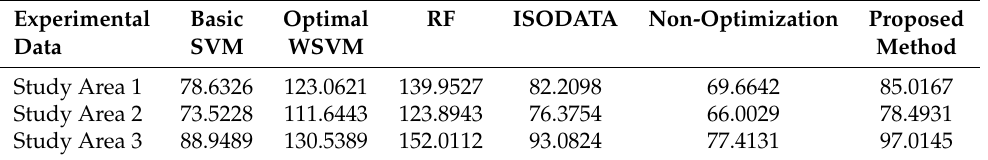
Table 3. CPU time of different methods (s).